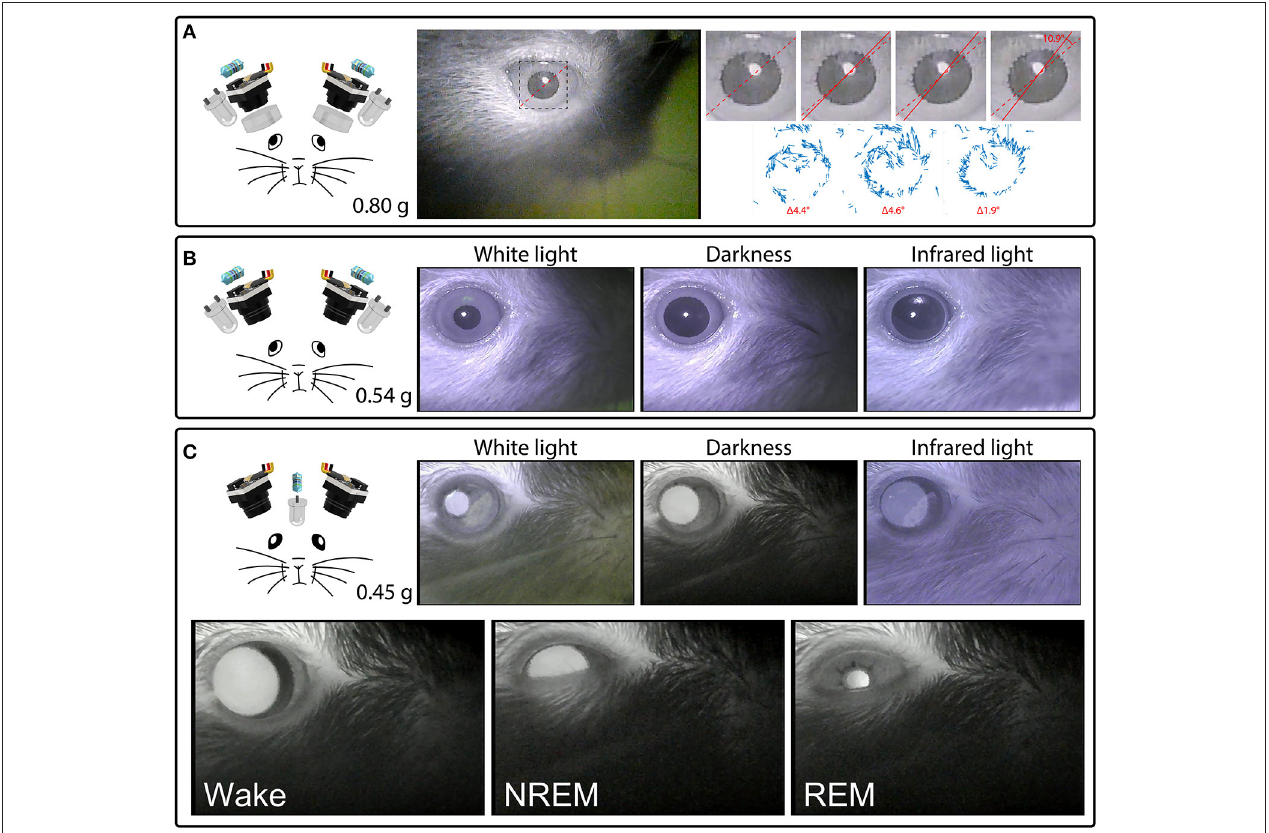
FIGURE 4 | Headset components pictured with their total weight (left) and examples of their video signals (right). (A) A camera headset consisting of two camera modules, resistors, external IR LEDs, and collimating lenses (left), and an example frame from Supplementary Video 4 , showing the right eye (middle). The inset marks the cropped location of the enlarged images of the pupil (right) from four consecutive deinterlaced frames of Supplementary Video 4 at 60Hz, with optic flow vector fields between successive frames shown underneath. Dashed red lines mark the orientation of prominent serrations across the pupillary rim of the iris in the first frame. Solid red lines track these serrations in consecutive frames. See Supplementary Video 4 for the full video. Optic flow was calculated in Matlab using the Lucas-Kanade derivative of Gaussian method with a noise threshold of 0.0005, and plotted with a scale factor of 100. (B) A camera headset consisting of two camera modules, resistors and external IR LEDs (left), and example frames of the video signals produced under white houselights, no houselights (darkness), and infrared houselights (right). See Supplementary Video 4 for example footage under white houselights. (C) A camera headset consisting of two camera modules, one resistor, and one IR LED chronically implanted above a cranial window for infrared back-illumination pupillometry (iBip), and example frames of the video signals produced under white houselights, no houselights (darkness), and infrared houselights (top right). See Supplementary Video 4 for example footage under white houselights, and Supplementary Video 5 for example footage in darkness, displaying the fundus, and optic disc. Example frames of wake, NREM sleep, and REM sleep recorded in the nest of the home cage (bottom). See Supplementary Video 6 for the full